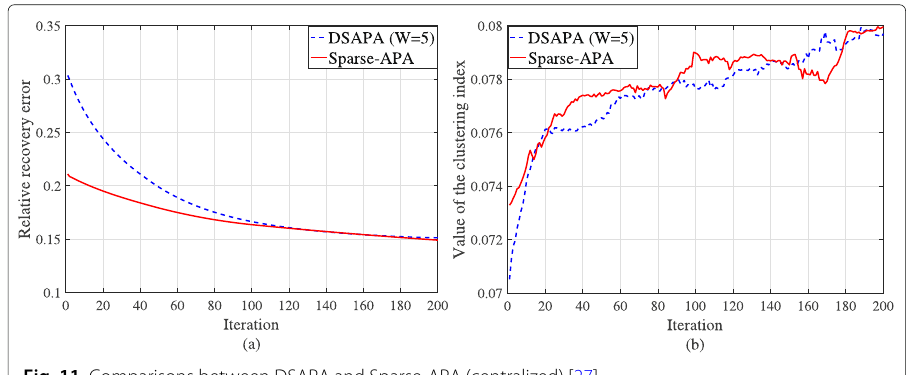
Fig. 11 Comparisons between DSAPA and Sparse-APA (centralized)